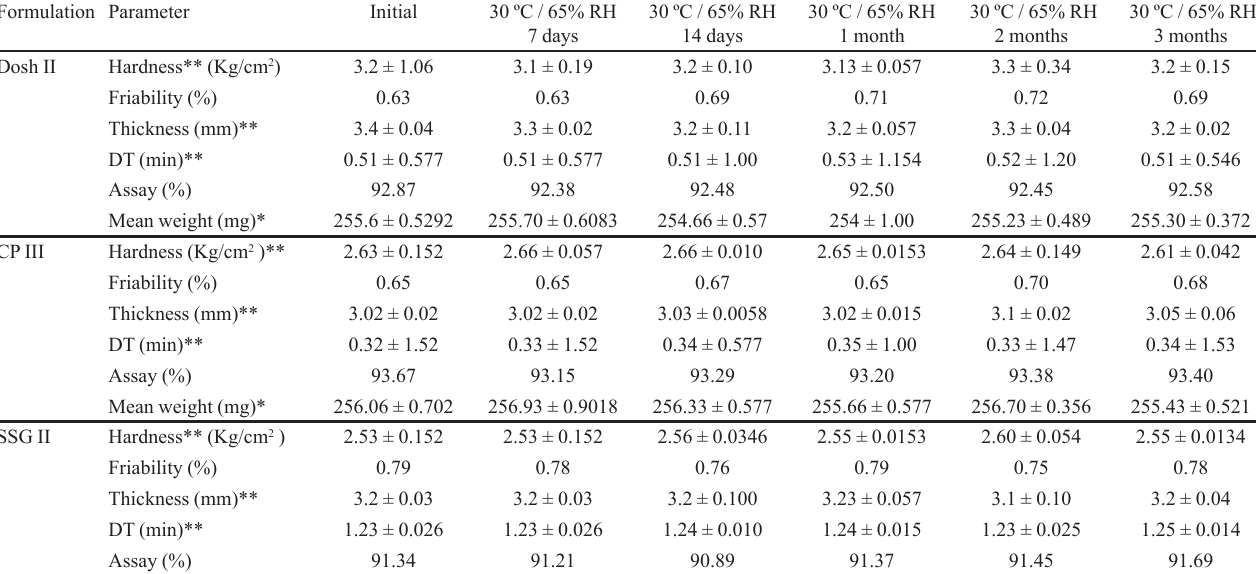
TABLE V - Stability Testing-i) 30 ± 1 o C and RH 65 % ± 5% Formulation